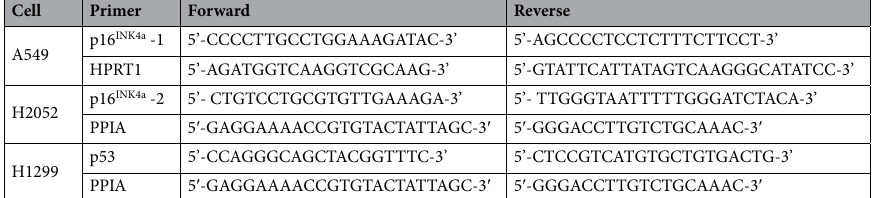
Table 2. Qualitative real-time PCR primer nucleotide sequences. For primer information, refer to the following references 37–41 . The primers were selected as appropriate during the actual